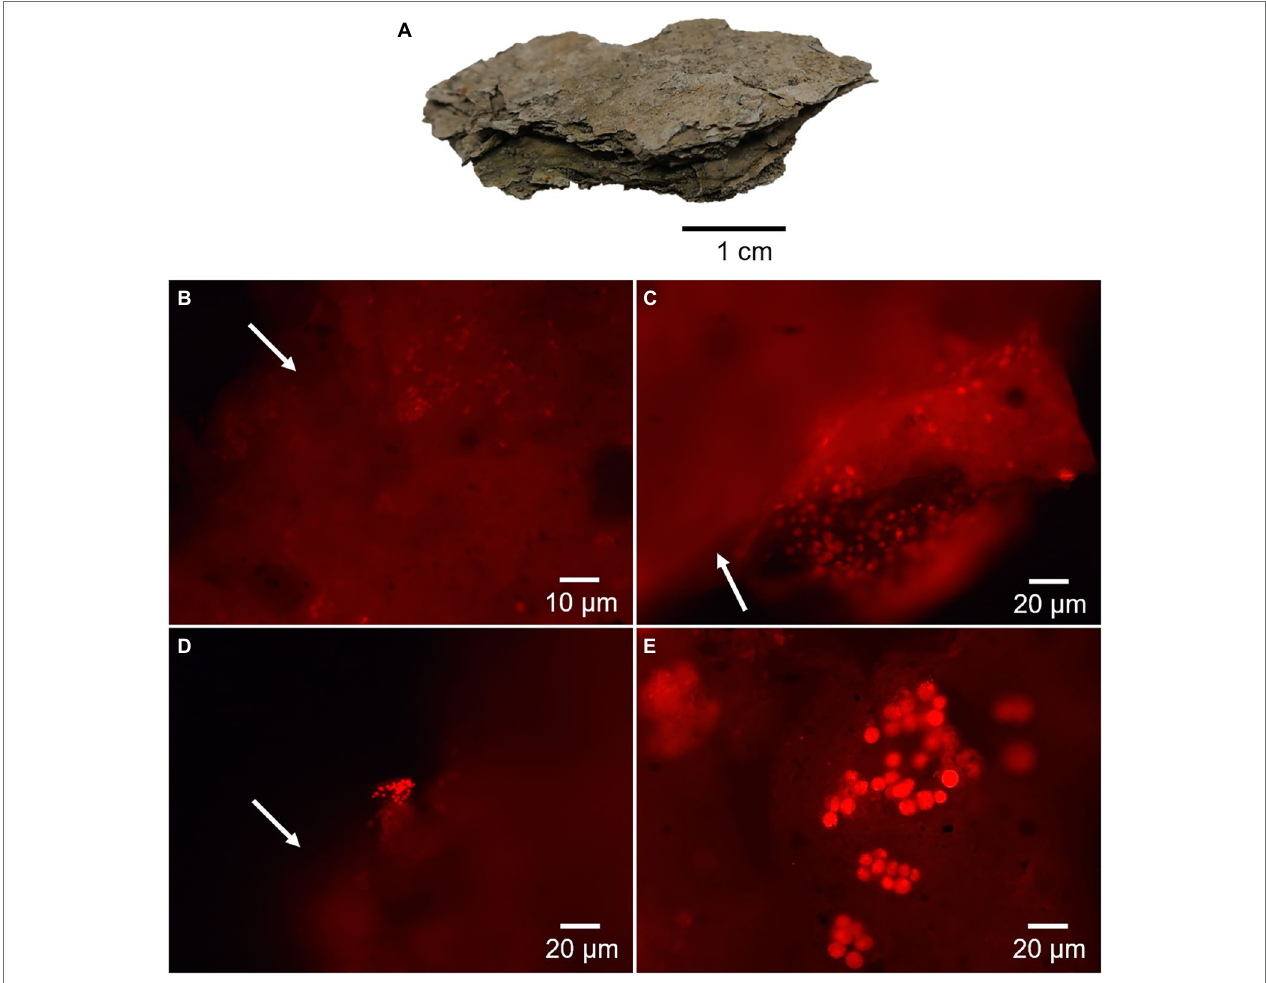
FIGURE 3 | Fluorescence microscopy images of the desiccated microbial mat showing red autofluorescence of chlorophyll-bearing cells. (A) Shows a picture of the dried and laminated microbial mat. Micrographs in (B,C) show remnants of photosynthetic cells with a large amount of cellular and extracellular material scattered outside the cells (arrows). The micrograph in (D) shows a possible colony of Cyanobacteria and release of photosynthetic pigments (arrow), and in (E) , a colony of microalgae with apparent entire